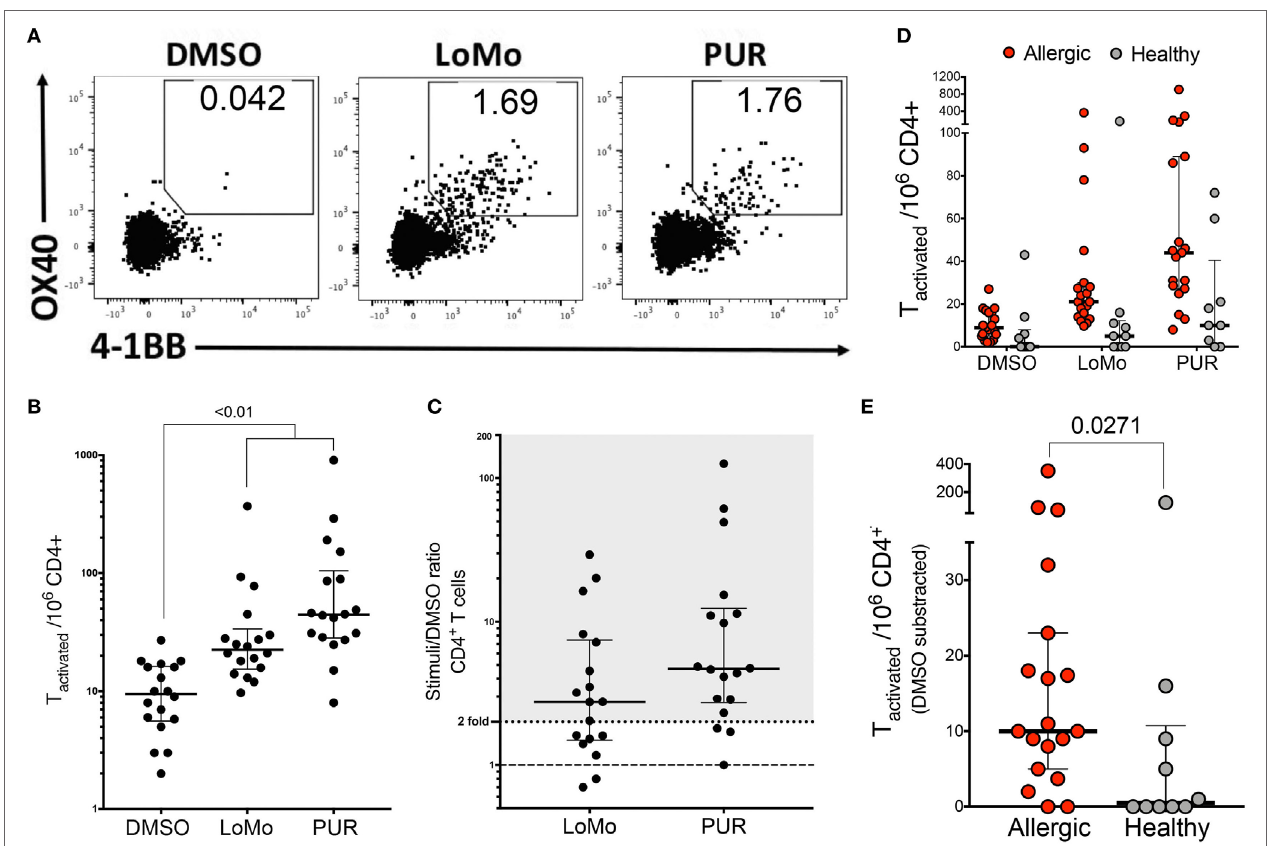
FigUre 5 | Ex vivo detection of human LoMo-specific CD4 + T cells. (a) Representative flow cytometry plots of 4-1BB + OX40 + upregulation by CD4 + T cells after stimulation with DMSO, LoMo, or PUR extract for 24 h. (B) Graph shows total number of stimulated 4-1BB + OX40 + CD4 + T cells per 1 × 10 6 PBMCs after AIM/4-1BB enrichment assays. Median ± interquartile range is represented for each stimulus. Statistical analysis was performed by Friedman’s non-parametric repeated measures comparisons. (c) Median of total number of activated T cells represented as fold over background (DMSO). Positive reactivity was defined as stimuli index > 2-fold. Each dot represents one donor. (D) Total number of allergic vs. non-allergic activated CD4 + T cells after AIM/4-1BB enrichment assays. Median ± interquartile range is represented for each stimuli (e) Median of total number of LoMo-specific T cells subtracted over background (DMSO). Each dot represents one donor. Statistical analysis was performed by two-tailed Mann–Whitney